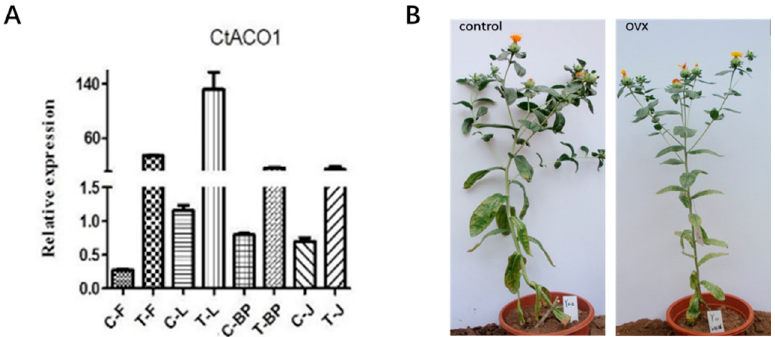
Figure 4. ( A ) Relative abundance of CtACO1 genes in flower (F), leaf (L), bracteole (BP) and stem (J) of control (C) and CtACO-overexpressing plants (T). ( B ) Phenotypic difference between WT (wild-type safflower line) and CtACO-overexpressing plants.